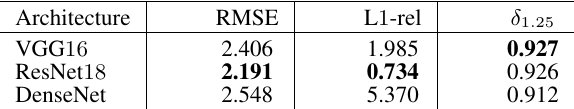
Table 3. Comparison of different network topologies used for the encoder.